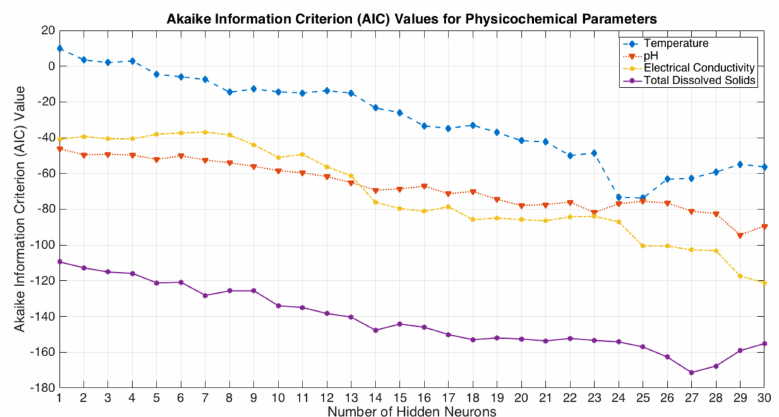
Figure 8. The AIC Values for Physicochemical Parameters.